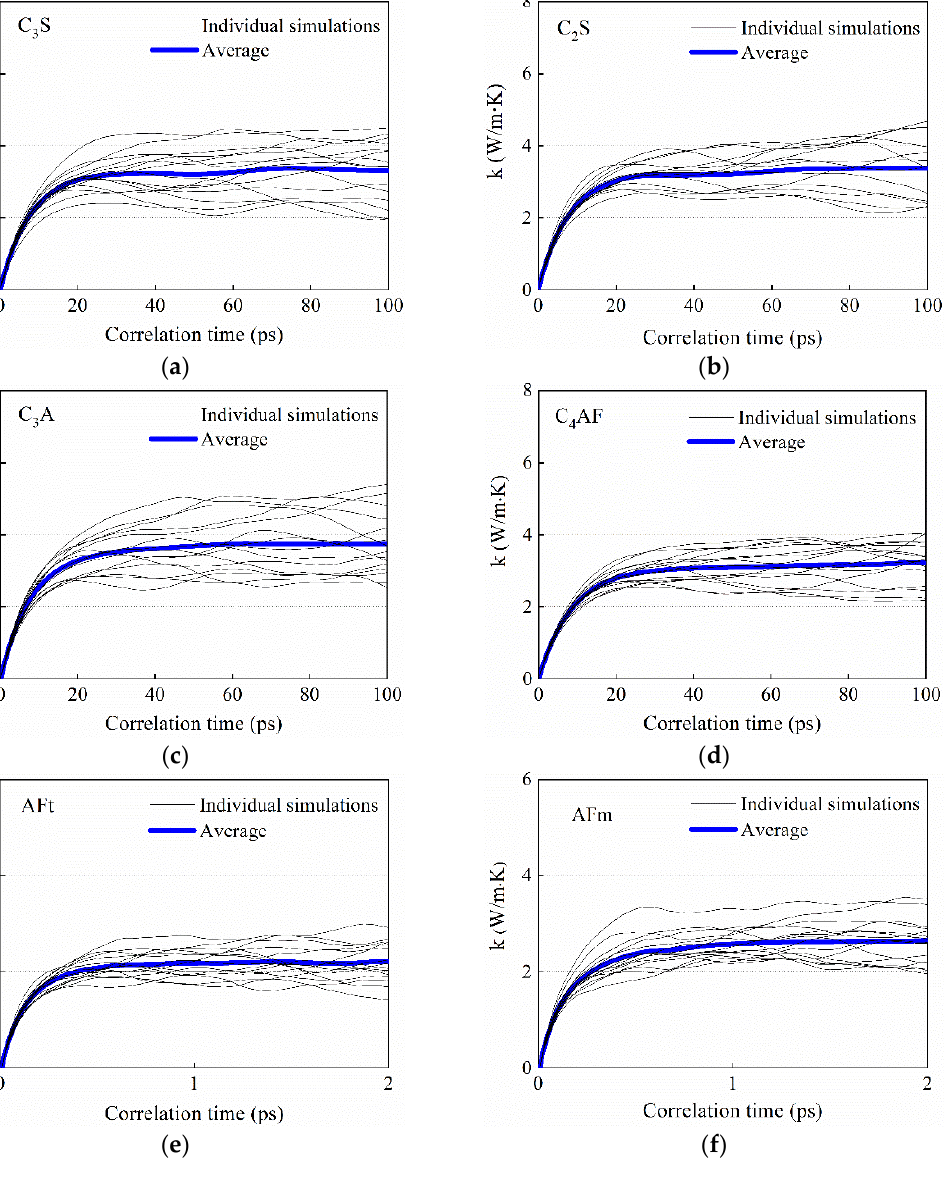
Figure 5. Running thermal conductivities as a function of correlation time for clinker phases and hydration products (the grey lines represent the independent simulation results, the blue lines represent the average value of 15 independent simulations): ( a ) C 3 S, ( b ) C 2 S, ( c ) C 3 A, ( d ) C 4 AF, ( e ) AFt, ( f ) AFm.